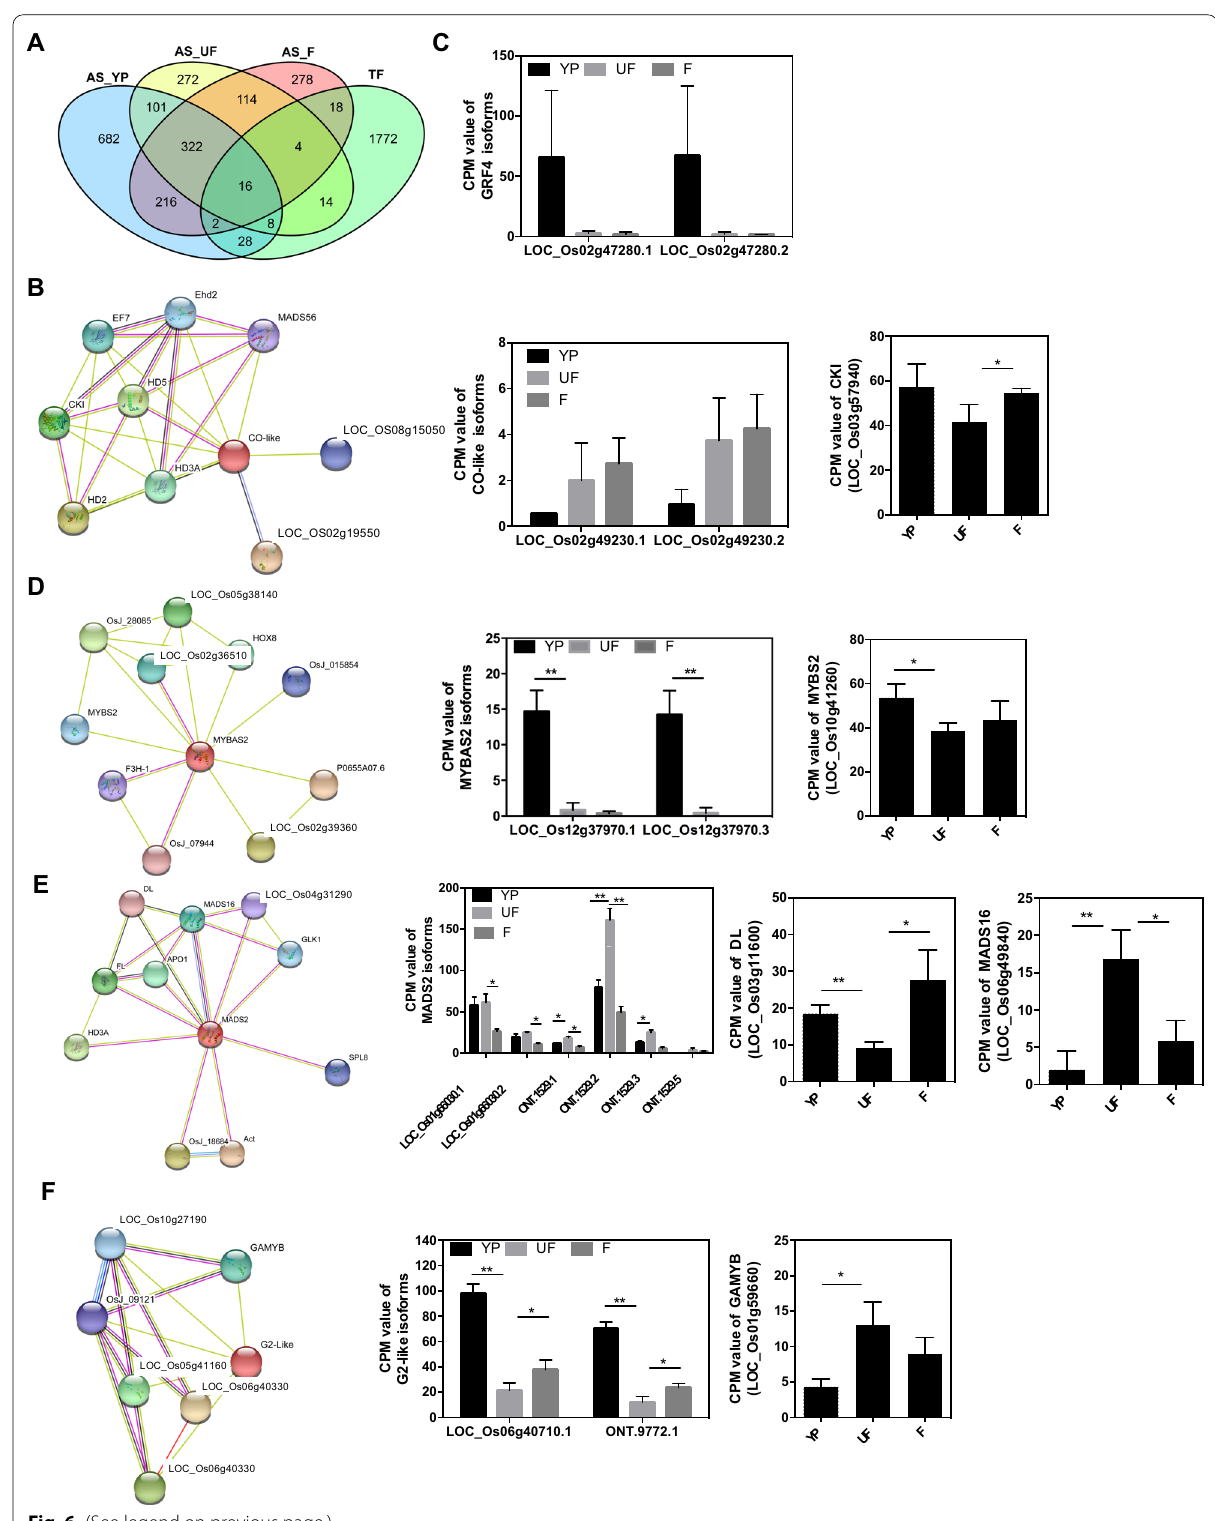
Fig. 6 (See legend on previous